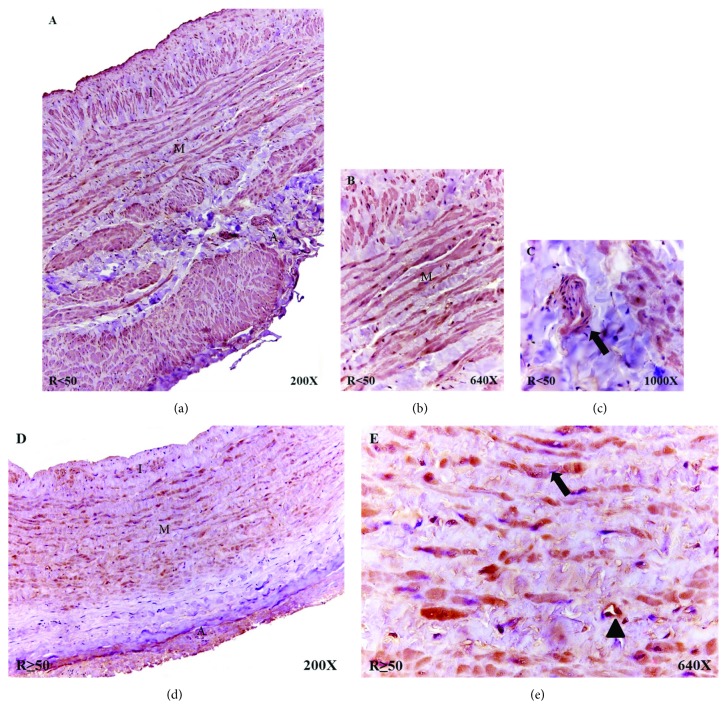
(a) Histological images for protein expression of mTOR in the different tunicae of the venous wall in R < 50 patients (200x). (b-c) Detail of expression for mTOR at greater magnification in media tunica (640x) and venula (arrow) in adventitia tunica (1000x). (d-e) Protein expression images of mTOR in R ≥ 50 patients, with detail in smooth muscle bundles (arrow) and blood capillary (arrowhead) in the tunica media (640x). The brown coloration indicates the specific precipitate that correlates with the expression of the said protein. A = tunica adventitia; M = tunica media; I = tunica intima.